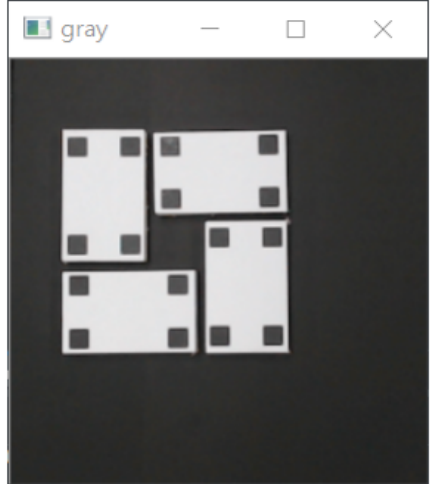
Figure 24 . Gray scale.